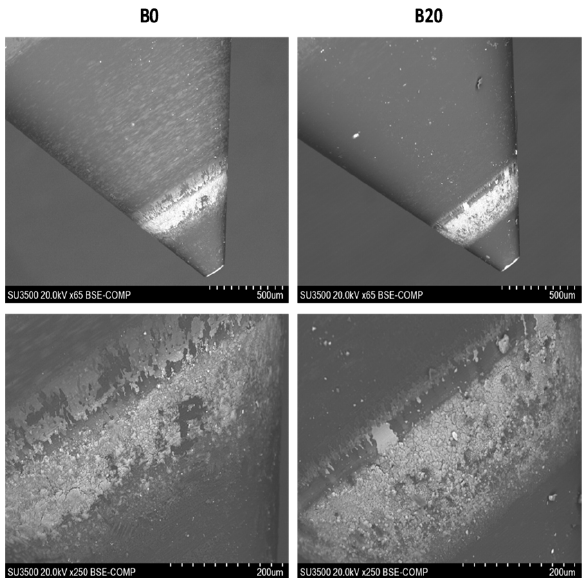
Figure 10. Injector needle deposits for B0 and B20.